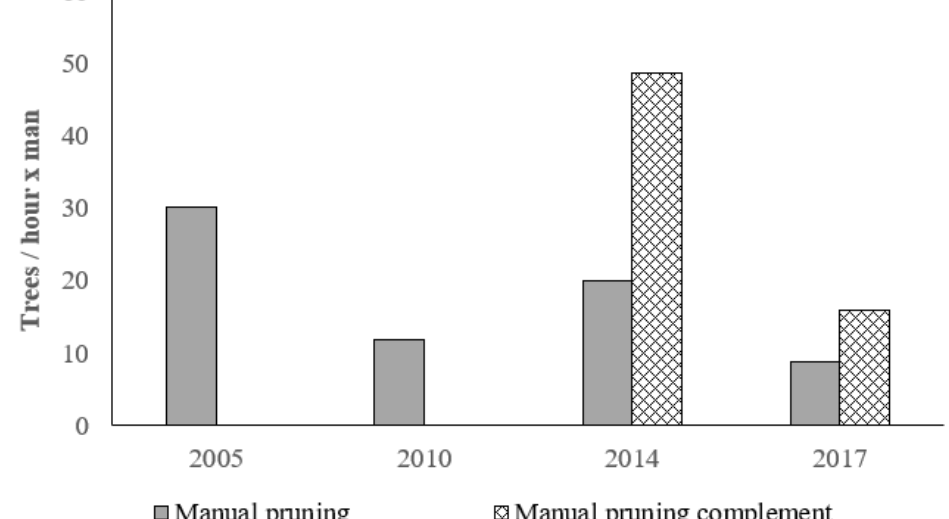
Figure 3. Average work rates of manual pruning.